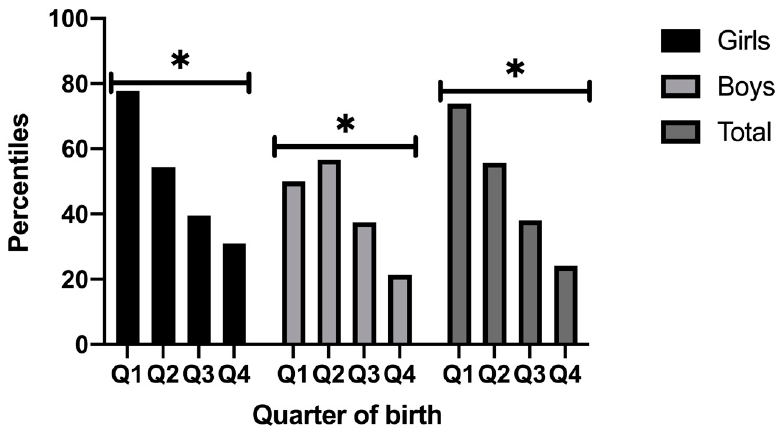
Figure 3. Percentiles according to gender and quarter of birth and global. Note: Q: Quarter of birth; * p < 0.001 different between quarter 1 vs. 2 vs. 3 and vs. 4.